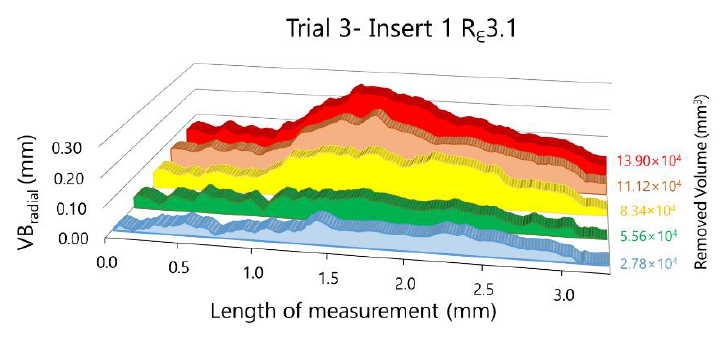
Figure 16. Evolution of VB radial.